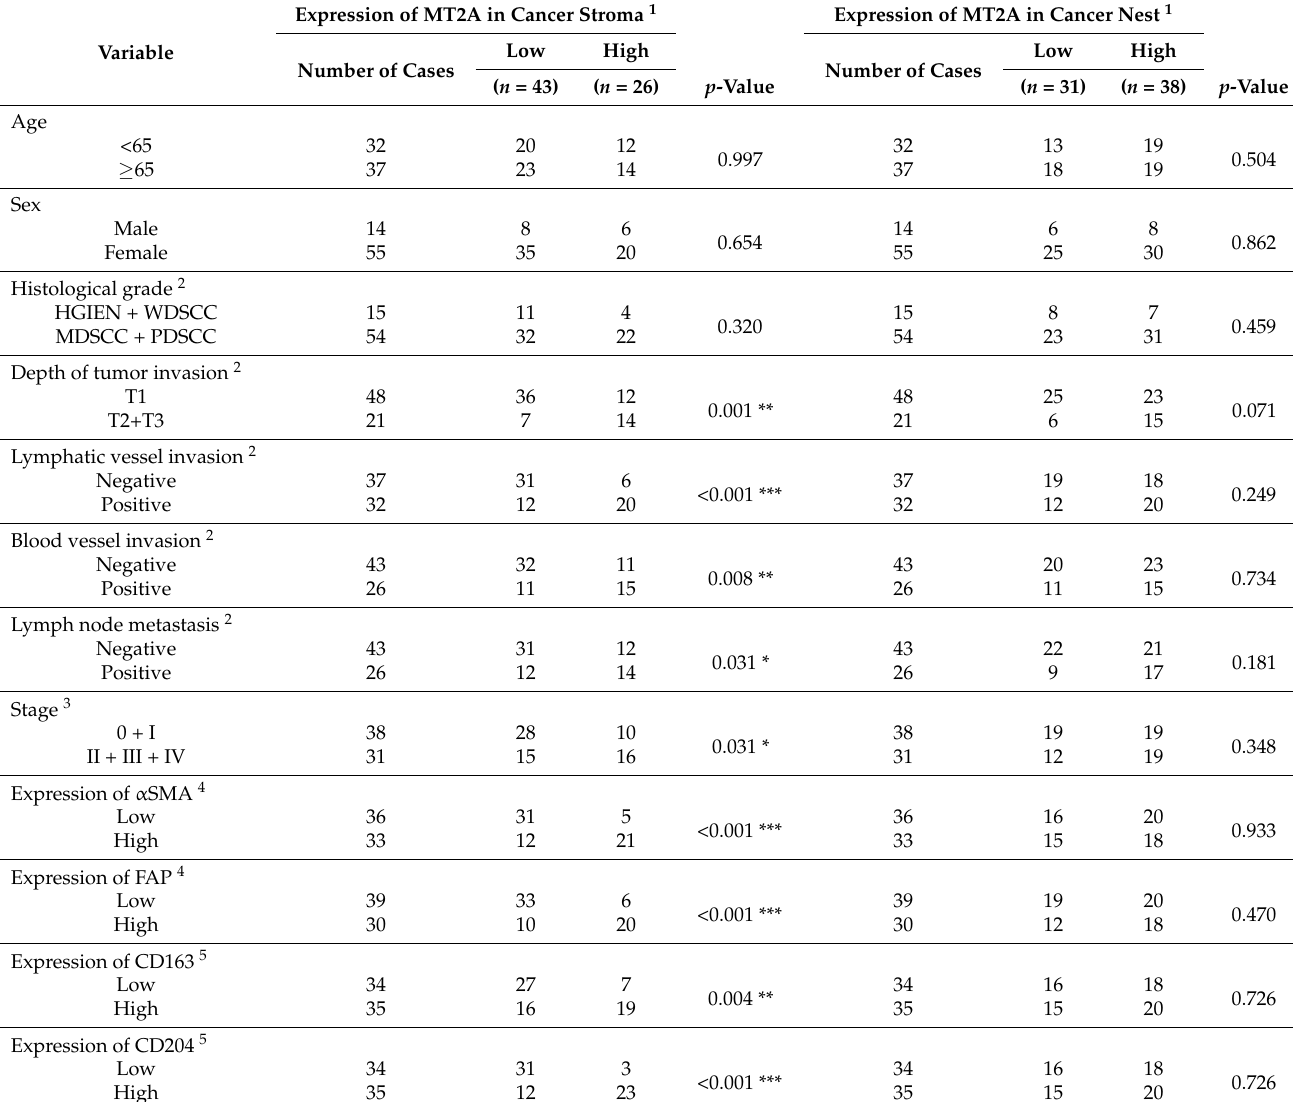
Table 1. Expression levels of MT2A in human ESCC tissues and their correlation with clinicopathological features.